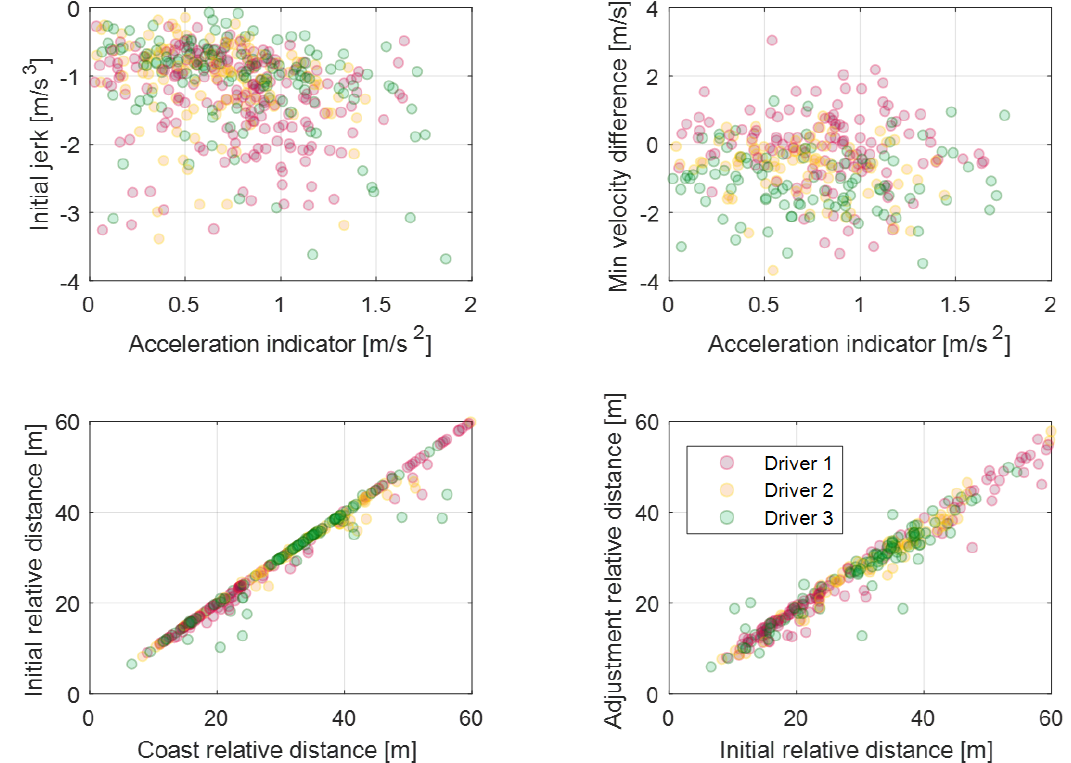
Figure 13. Model parameters and the parameter indices for dynamic deceleration